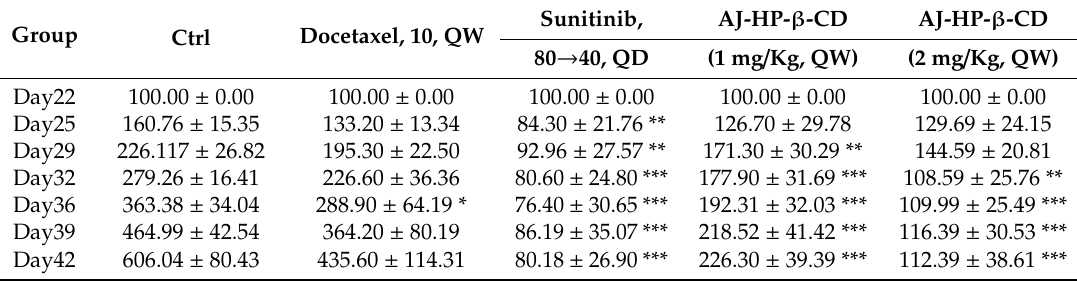
Table 2. Tumor volume of mice (mm 3